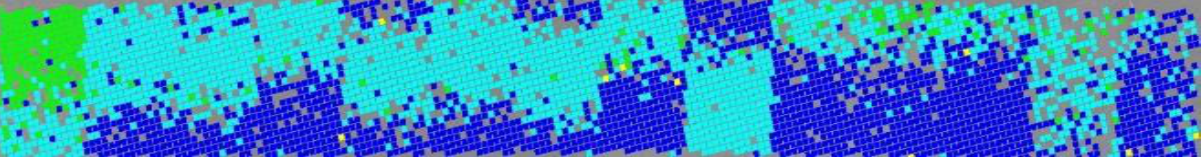
Figure 4. Pixel offsets plotted against the reference product (green: error < 0.5, cyan: 0.5 < error < 1, blue: 1 < error < 2, yellow: error > 2 pixels)